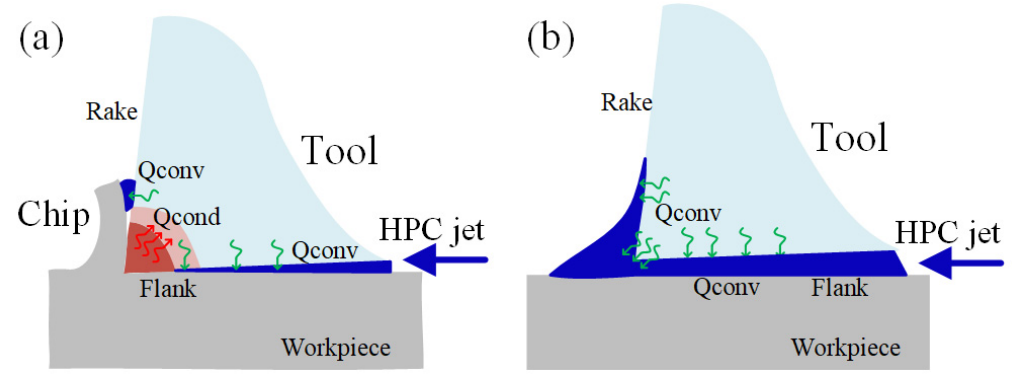
Figure 5. Heat transmission on the tool: ( a ) conventional milling (CM) with HPC and ( b ) HRUEM with HPC in non-cutting duration.